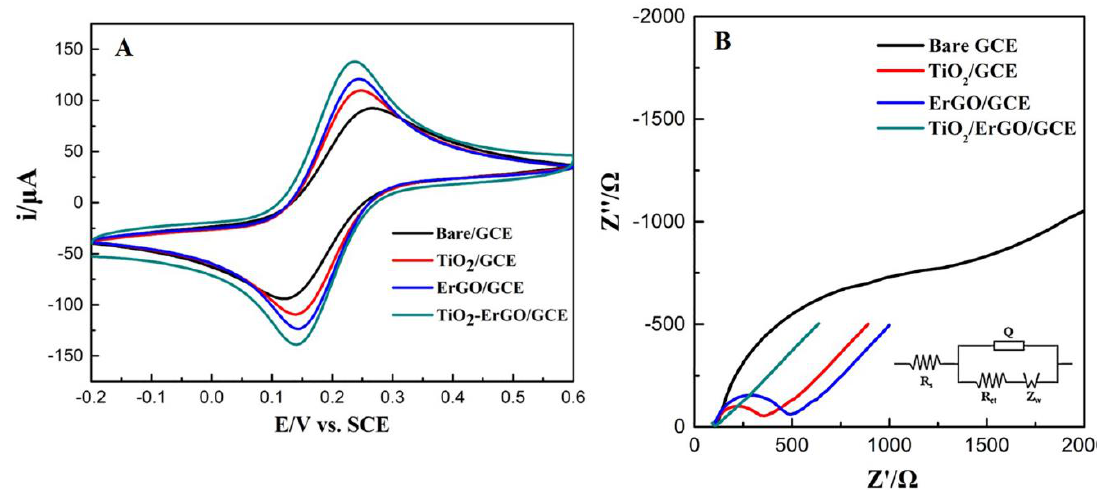
Figure 4. Cyclic voltammograms ( A ) and Nyquist plots ( B ) measured at different electrodes in 0.1 mM [Fe(CN) 6 ] 3 − /4 − and KCl mixture solution. The inset in Figure 4B represents the equivalent circuit model.